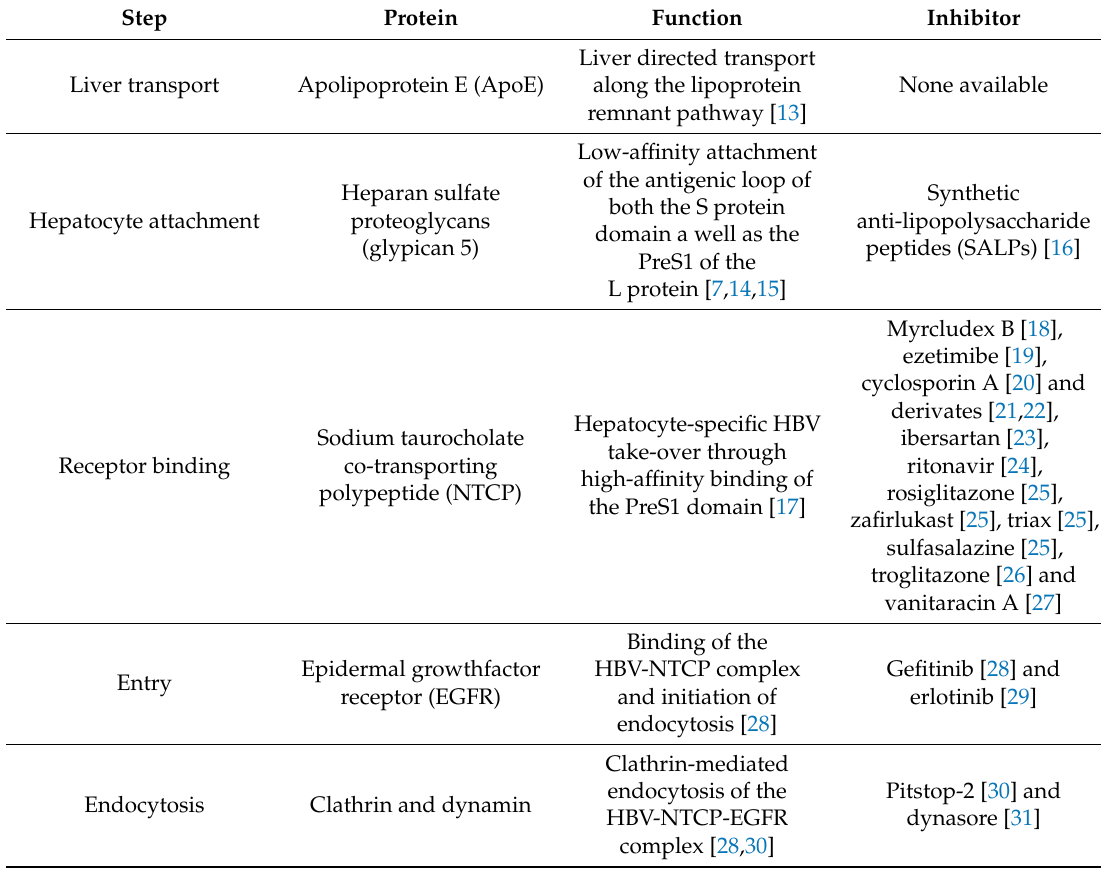
Table 1. Factors involved in the early steps of the hepatitis B virus (HBV) replication cycle and their